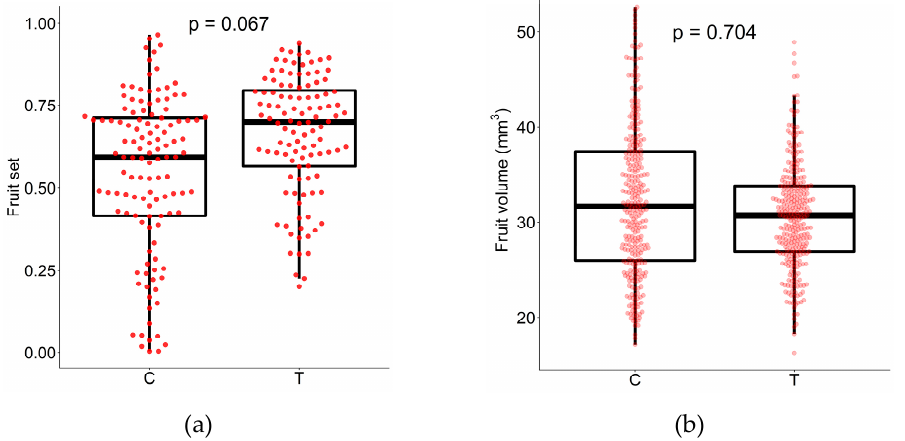
Figure 1. ( a ) Fruit set for inflorescences from the control (C) and treatment (T) individuals (12 control and 12 treatment trees). Each red closed circle indicates one inflorescence (i.e., bee swarm plots superimposed on box plots), and its vertical position indicates the value of the fruit set of that inflorescence. Each circle was shifted in the horizontal direction so as not to overlap with others ( n = 120 and 108 infructescences for C and T, respectively). The treatment group showed higher fruit set (GLMM (Gamma), p = 0.067), supporting the wider-choice hypothesis. ( b ) The volume of the fruits (three treatment (T) and three control (C) trees). Each red circle indicates one fruit ( n = 300 fruits for each of T and C). No significant difference was found between the two groups (GLMM (Gamma), p = 0.704). Table 1. Seed number per fruit. Number of Seeds Within Each Fruit